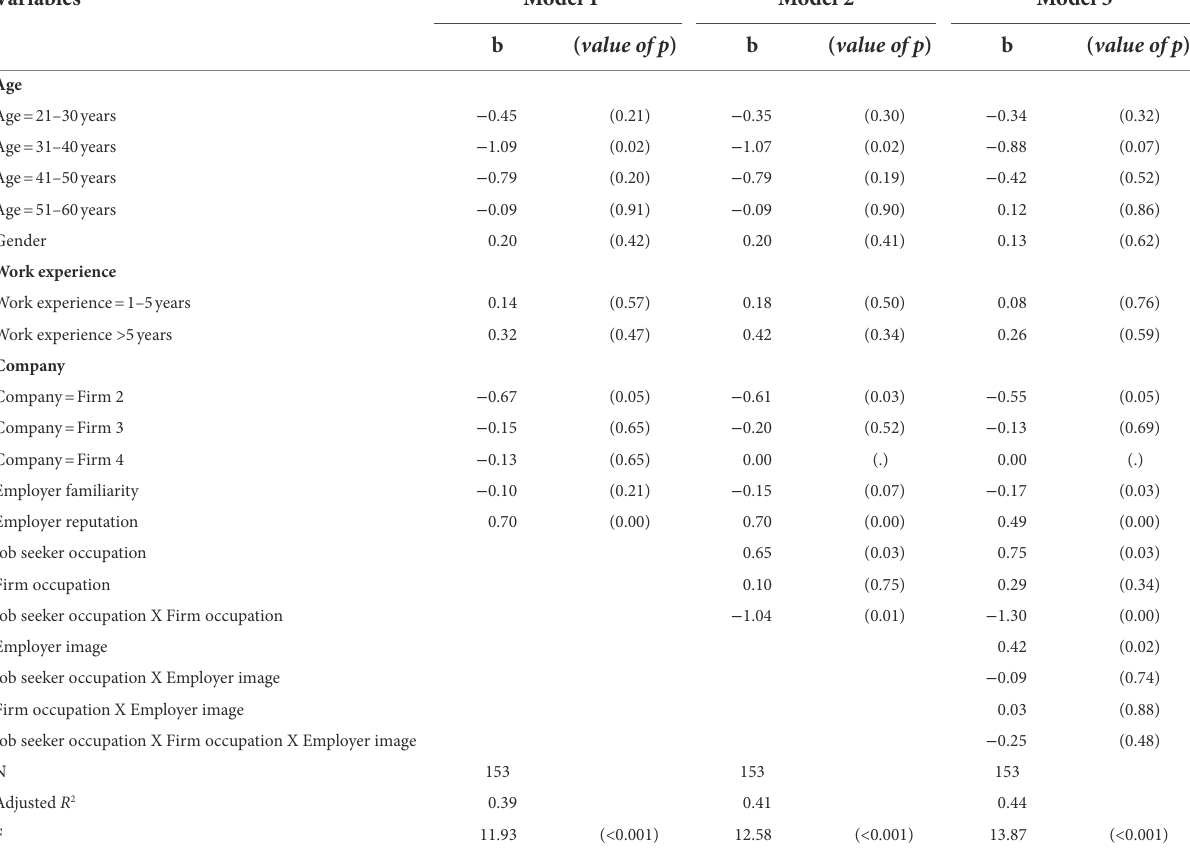
TABLE 3 Results of linear regression analyses on employer